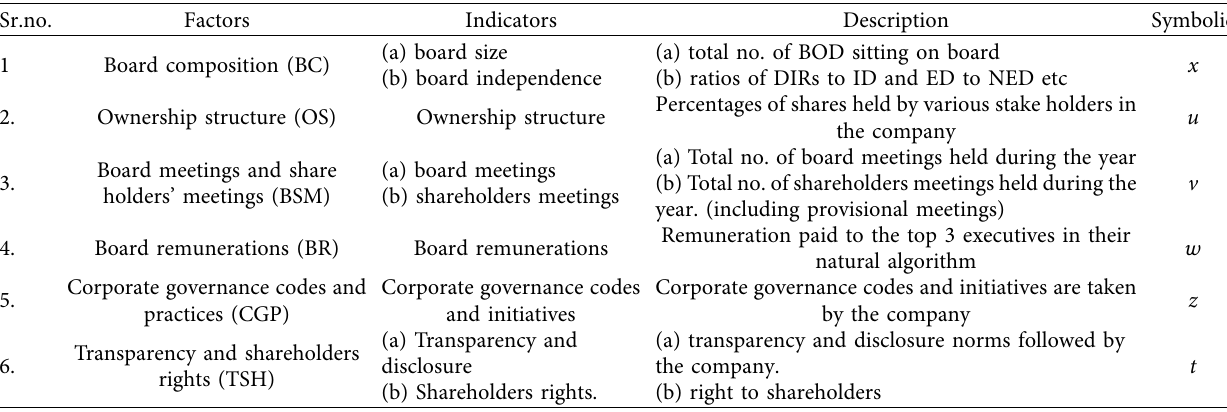
Table 1: Independent variables.